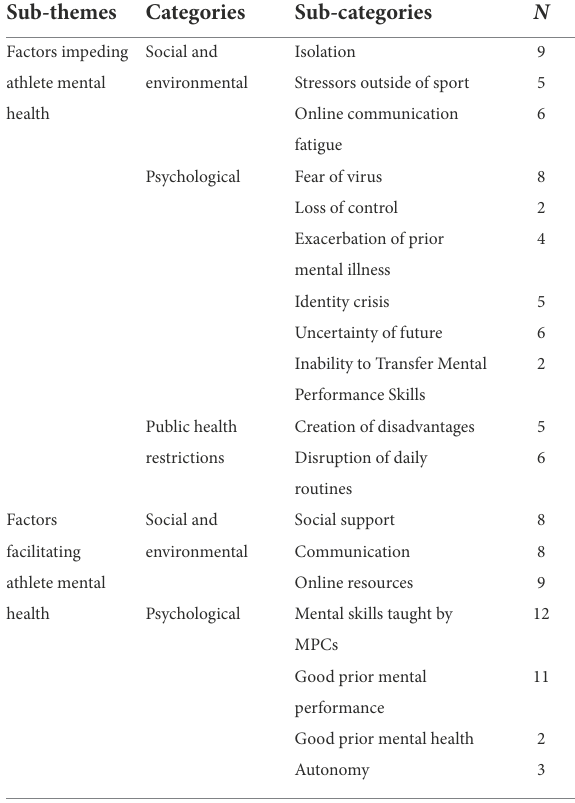
TABLE 2 Factors impacting athlete mental health.